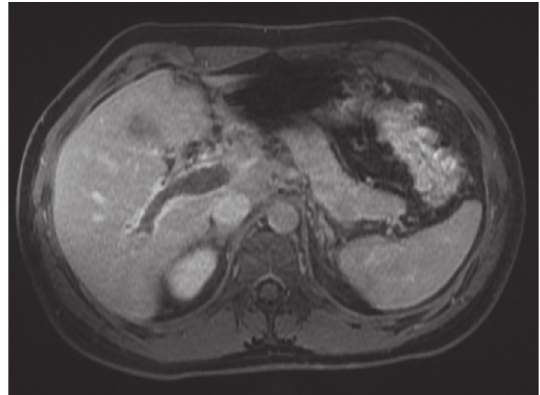
Figure 2: MRI of abdomen and pelvis with portal vein